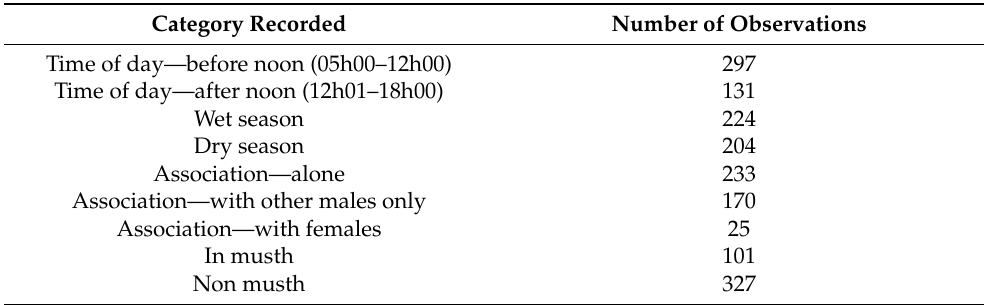
Table 2. Number of observations made for each category tested throughout the study period. All behavioural observations during the time Bulls 1 and 3 were injured were